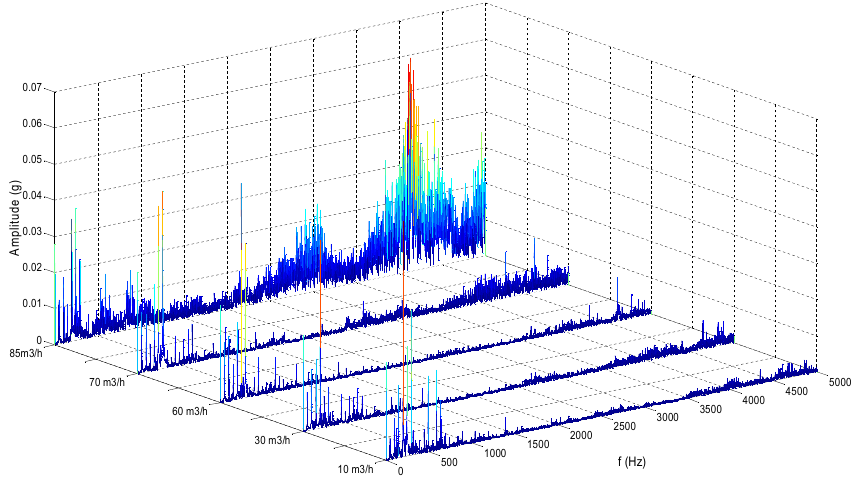
Figure 7. Vibration spectra of the centrifugal pump under five typical flow conditions.